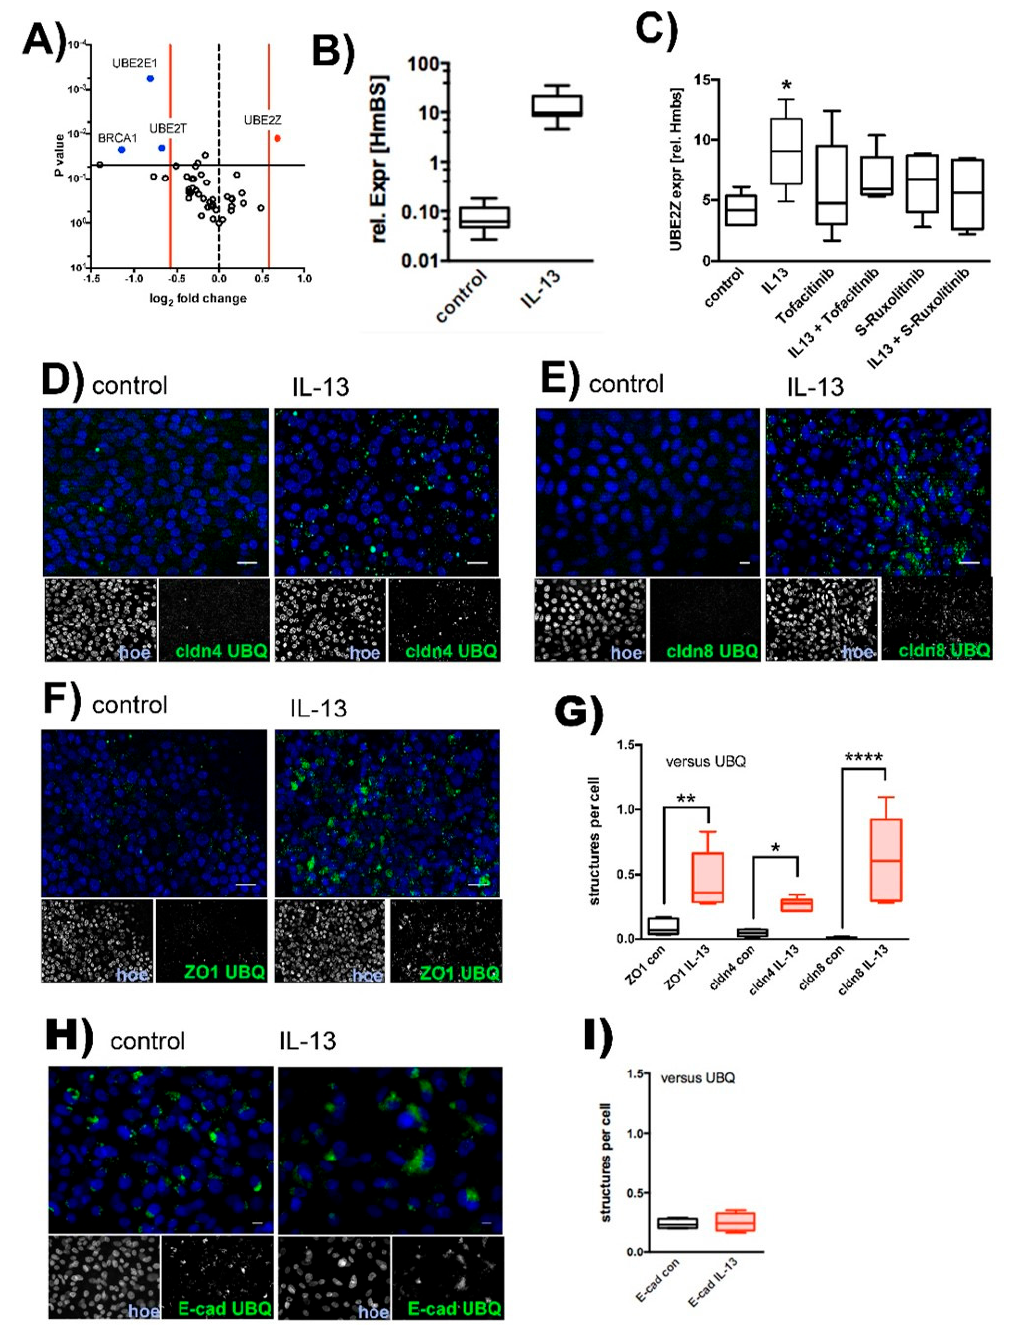
Figure 4. Ubiquitination of TJ proteins. Human tracheal epithelial cells were cultivated at air-liquid interface conditions in the absence (control) and presence of IL-13 (IL-13). ( A ) Screening for ubiquitin activating E1 and ubiquitin conjugating E2 enzyme by semi-quantitative RT-PCR. Volcano plot summarizes changes in expression levels (control vs. IL-13, each N = 3). Log2 fold changes are given as mean values. Vertical red lines give threshold of ± 1.5 fold change. Horizontal black line gives threshold of p = 0.05. Genes that were considered to be up regulated are depicted in red (UBE2Z) and those to be down regulated are given in blue (BRCA1, UBE2T, UBE2E1). ( B ) Upregulation of UBE2Z by IL-13 was confirmed and effect of JAK/STAT pathway inhibition was tested in subsequent independent experiments. Relative expression of UBE2Z to HmBS of: control epithelia (control, p = 0.021), epithelia cultivated in the presence of IL-13 (IL-13), 2.5 µM Tofacitinib (Tofacitinib, p = 0.035) or S- Ruxolitinib (S-Ruxolitinib, p = 0.16) and in the presence of IL-13 + Tofactinib ( p = 0.16) or IL-13 + S- Ruxolitinib ( p = 0.09). All versus IL-13 and N = 6, ANOVA with Holm-Sidak correction for multiple testing. ( C ) IL-13 stimulation of epithelia used in “B” was confirmed by detecting Muc5ac